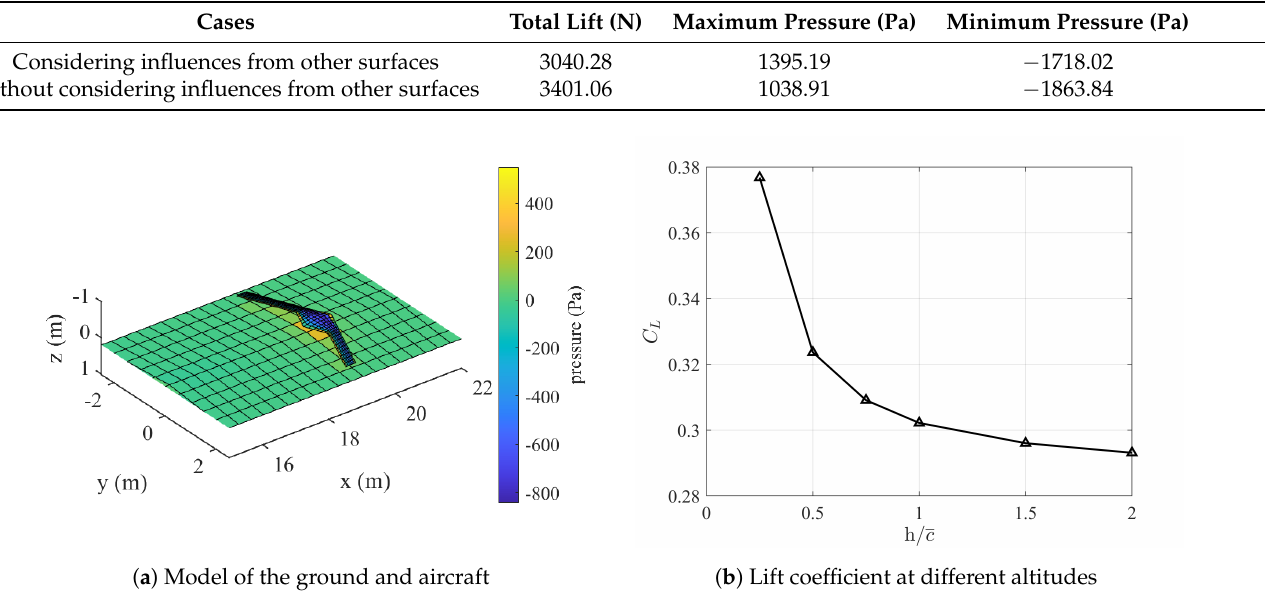
Figure 14. Example of non-lifting surface modeling: ground effect.